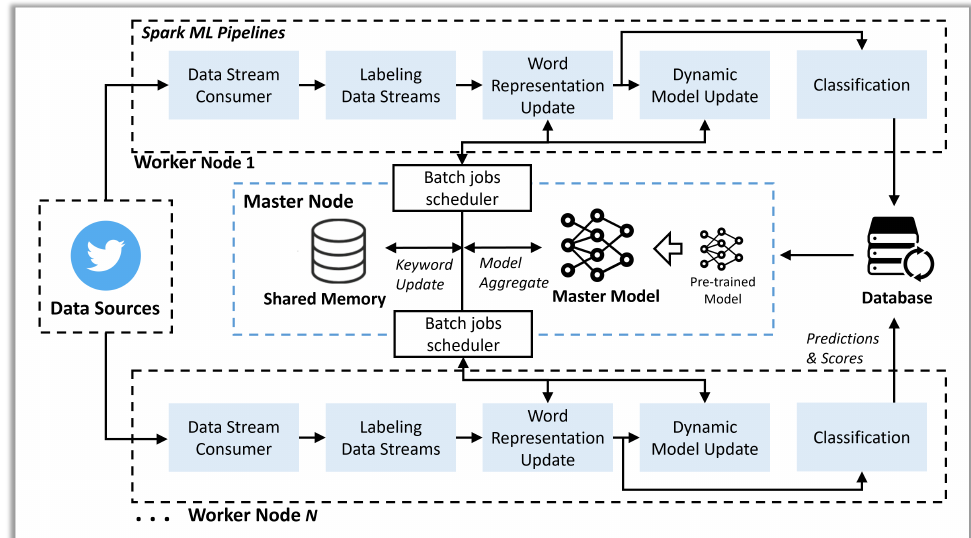
Figure 1. Overall framework